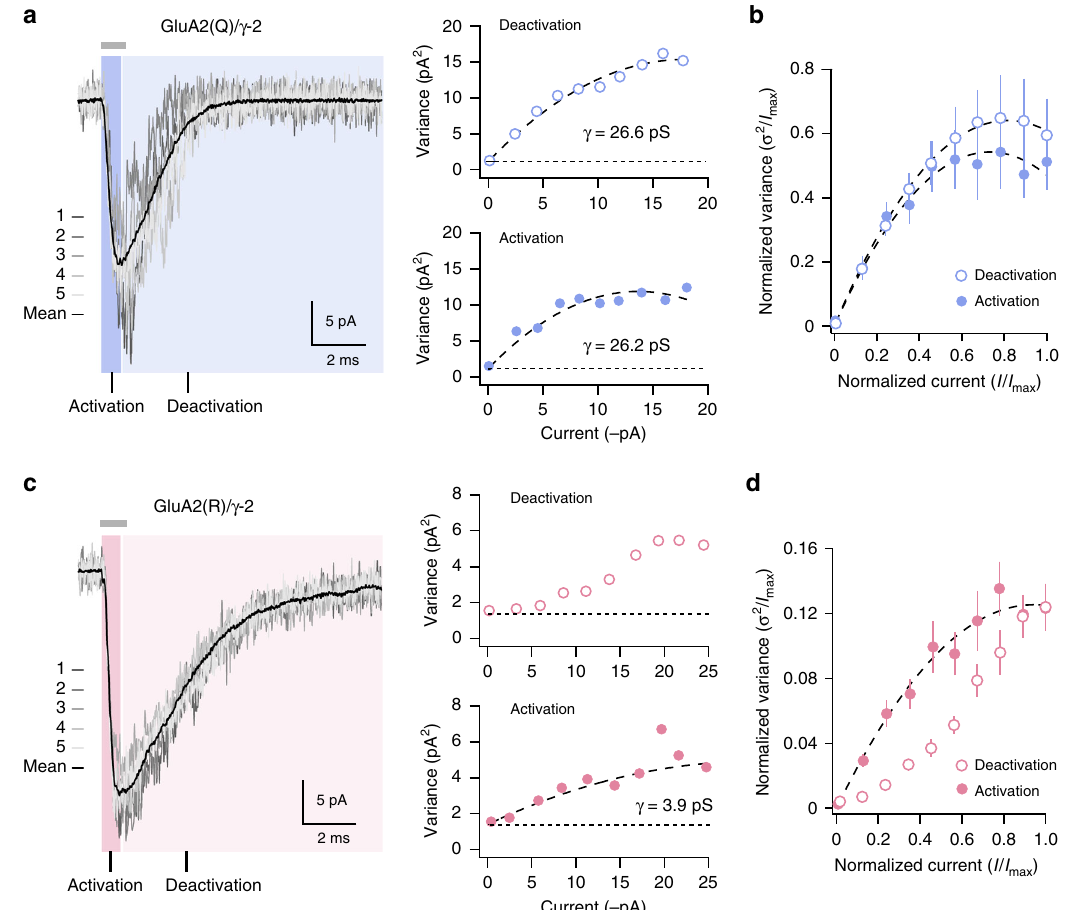
Fig. 3 Estimated weighted mean conductance from NSFA of GluA2(R)/ γ -2 activation. a Representative GluA2(Q)/ γ -2 responses to 1 ms (gray bar) glutamate application (gray traces) with superimposed average (black trace). NSFA was performed on the activation phase (blue highlight; fi lled blue circles) and deactivation phase (light blue highlight; open blue circles) of the same records, yielding similar estimates of weighted mean conductance. b Pooled current – variance plots for the activation and deactivation of GluA2(Q)/ γ -2 currents ( n = 5). Error bars indicate s.e.m. c Representative GluA2(R)/ γ -2 response to 1 ms glutamate application (as in a ). NSFA was performed on the activation phase (pink highlight; fi lled pink circles) and deactivation phase (light pink highlight; open pink circles) of the same records. Current – variance relationship is non-parabolic for deactivation but parabolic for activation. d Pooled current – variance plots for the activation and deactivation of GluA2(R)/ γ -2 currents ( n = 8). Error bars indicate